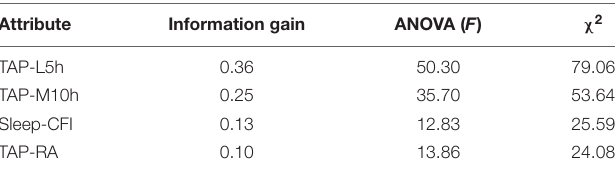
TABLE 2 | Information gain, ANOVA F , and χ 2 for every attribute selected for building the decision tree (see Figure 1 for legend). Attribute Information gain ANOVA ( F